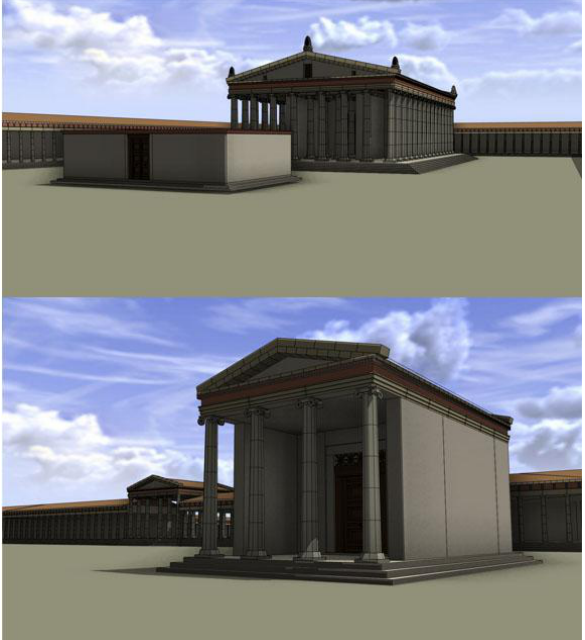
Figure 3. Two Ionic Temples generated from the same procedural rule: the temple of Artemis (top) and Zeus (bottom) at Magnesia on the